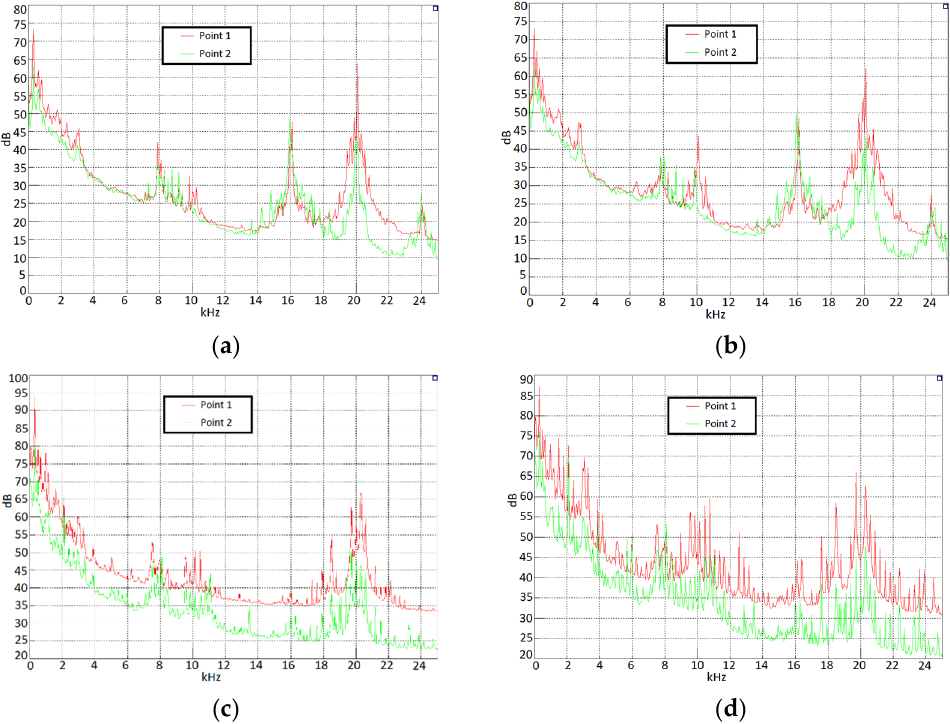
Figure 22. Power spectrum of noise signal measured by two different microphones—next to the machine (red) and 1.5 m above the machine (green) at 45 deg current angle: ( a ) 1000 rpm 20 Nm; ( b ) 1000 rpm 60 Nm; ( c ) 4500 rpm 20 Nm; and ( d ) 4500 rpm 60 Nm. Comparison of the noise power spectrum measured at different rotational speeds is shown in Figure 23.